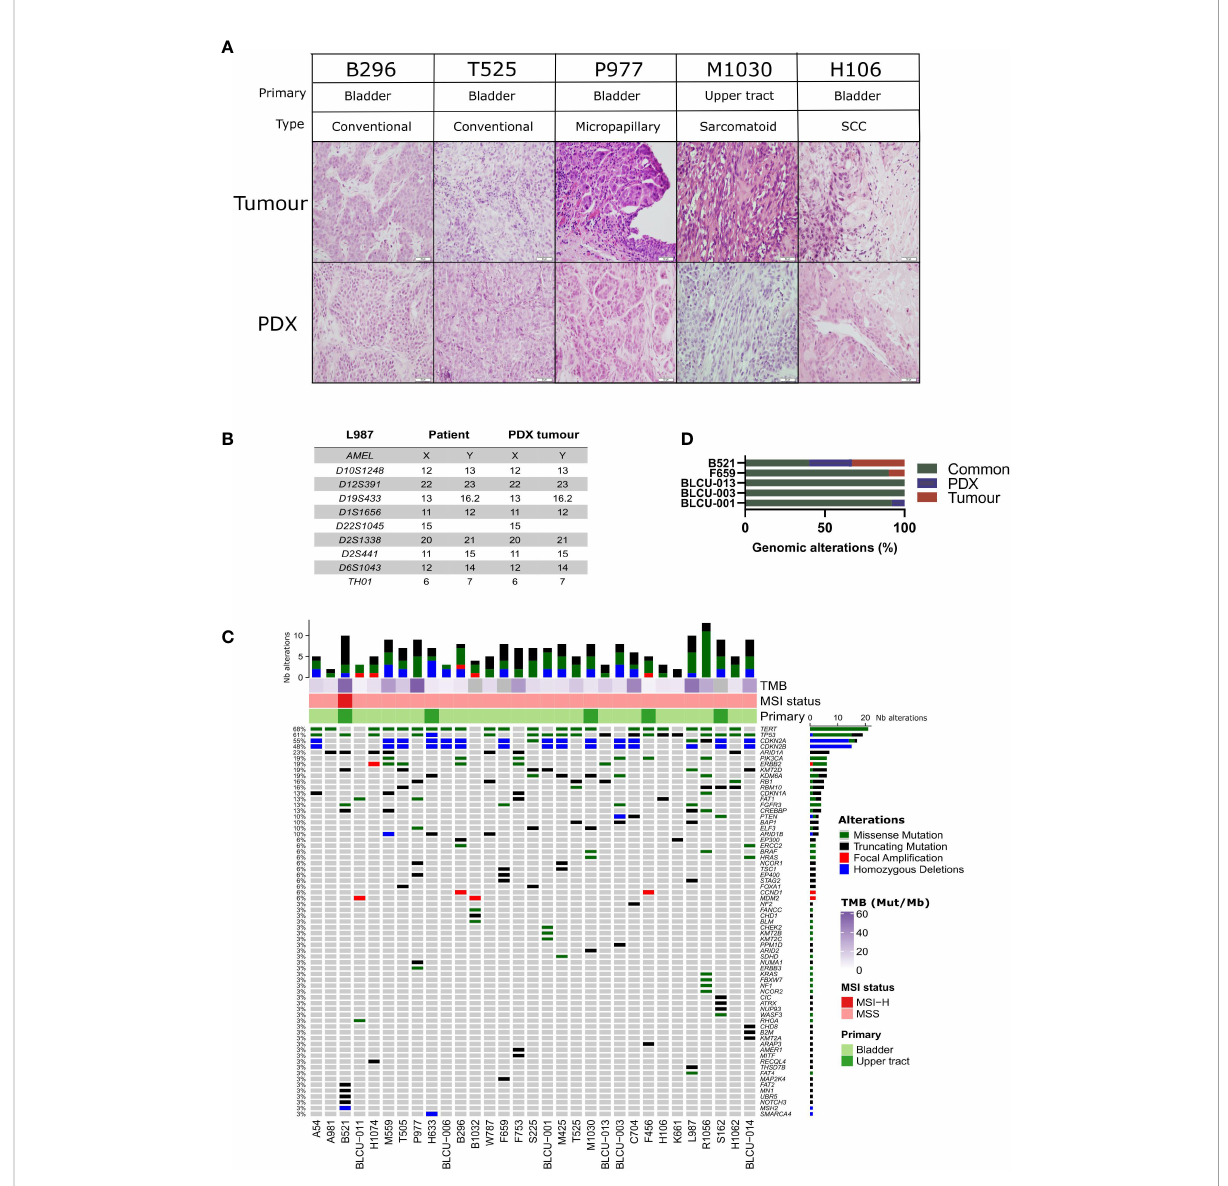
FIGURE 1 Histological and genomic characteristics of patient tumors and paired derived patient-derived xenografts (PDXs). (A) Histology of bladder/ ureteral patient tumors and corresponding PDX models demonstrated similar histological features as assessed by hematoxylin and eosin (H&E) staining. Scale bar corresponds to 50µm. H&E slides of a section of each patient tumor and matching PDX were reviewed by a board-certi fi ed pathologist, and representative pictures for the different histologies or variants are shown. (B) Short tandem repeat signature of a patient specimen and PDX tumor, an example of the L987 case. (C) Somatic genomic landscape of 31 bladder and ureteral PDXs analyzed using an in- house targeted sequencing assay (571 cancer-related genes, Supplementary Tables 2, 3), the tumor mutational burden per megabase (TMB, indicated in the log2 scale for each sample), and microsatellite instability – high (MSI-H) versus a microsatellite-stable (MSS) status. (D) Concordance of genomic alterations in fi ve pairs